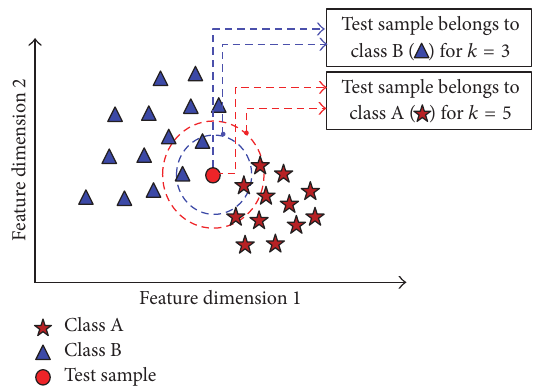
Figure 1: Limitation of classical 𝑘 -NN using only the distance based similarity